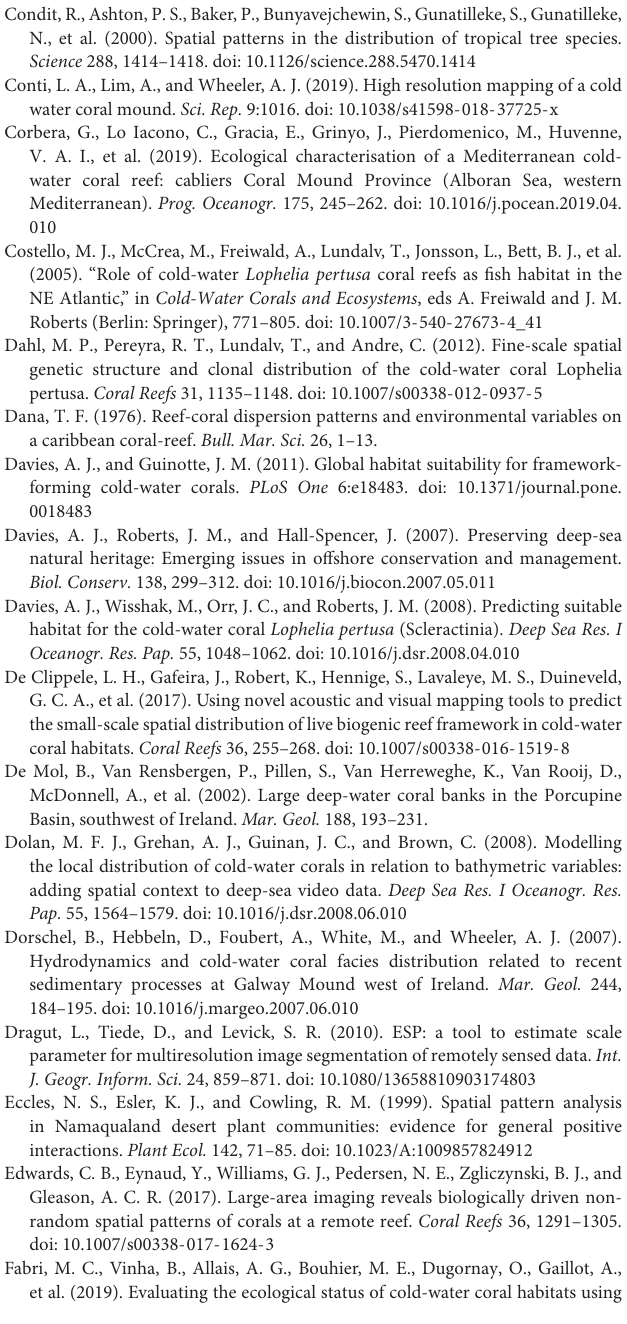
Supplementary Figure 1 | Images of all species. (A) Aphrocallistes sp., (B) Desmophyllum pertusum , (C) Madrepora oculata , (D) Stichopathes sp., (E) Psolus sp., (F) Galatheoidea sp., (G) Gracilechinus sp. “green”, (H) Anthomastus sp., (I) Callogorgia sp., (J) Gracilechinus sp. “pink”, (K) Alcyonacea spp., (L) Cidariscidaris , (M) Zonathidae sp. Supplementary Figure 2 | Kernel density plots for all species at Site A. Supplementary Figure 3 | Kernel density plots for all species at Site B. Supplementary Figure 4 | Kernel density plots for all species at Site C. Supplementary Figure 5 | Pair correlation function of Aphrocallistes sp. at Site A compared to the models representing CSR, IP (Northness, Vector Ruggedness